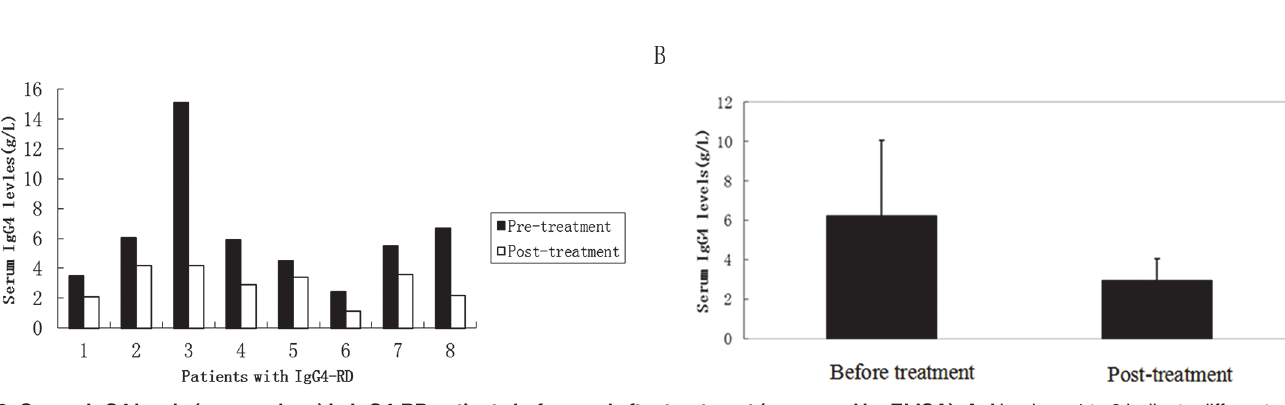
Fig 3. Serum IgG4 levels (mean values) in IgG4-RD patients before and after treatment (measured by ELISA). A: Numbers 1 to 8 indicate different patients. Serum IgG4 titers of 8 participants with IgG4-RD were compared before and after treatment. The follow-up time was 1 to 14 months. B: A comparison of the mean serum IgG4 levels from 8 IgG4-RD patients before and after treatment. (mean ± SD = 6.21 ± 3.86g/L vs. 2.96 ± 1.10g/L). The Wilcoxon matched-pairs signed-ranks test was applied to compare serum IgG4 concentrations; P <